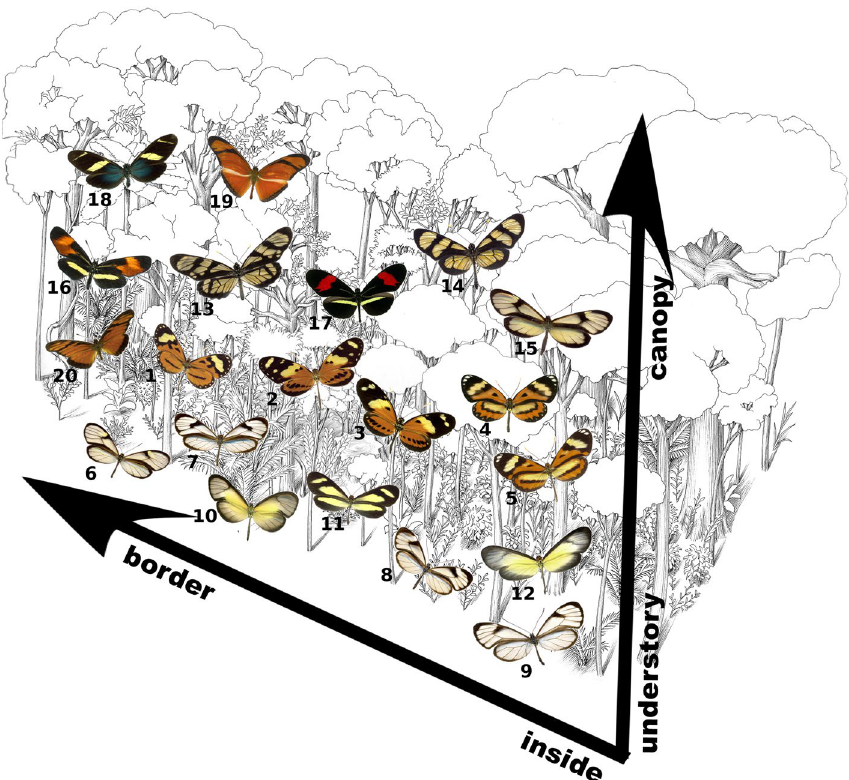
Figure 1. Examples of coexisting mimicry rings in the same local community: tiger (species 1, 2, 3, 4 and 5), blue clearwing (species 6, 7, 8 and 9), yellow clearwing (10, 11 and 12), Methona (13, 14 and 15), erato (16 and 17), sara (18) orange (19 and 20) These butterflies are habitat specialists, using for example a specific part of the forest, such as a certain high of the forest (vertical stratification 37 ) or the border of the forest 54 . Species: 1. Hypothyris euclea laphria ; 2. Melinaea ludovica parayia ; 3. Heliconius numata robigus ; 4. Placidina euryanassa ; 5. Hypothyris ninonia daeta ; 6. Episcada striposis ; 7. Ithomia drymo ; 8. Hypoleria alema proxima ; 9. Pseudoscada acilla acilla ; 10 . Episcada hemixanthe ; 11. Aeria olena ; 12. Scada karschina karschina ; 13. Lycorea ilione ; 14. Methona themisto ; 15. Episcada philoclea ; 16. Eresia lansdorfi ; 17. Heliconius erato phyllis ; 18. Heliconius sara ; 19. Dryas iulia ; 20. Dione juno juno . (Background art by Danilo B. Ribeiro and Rogério